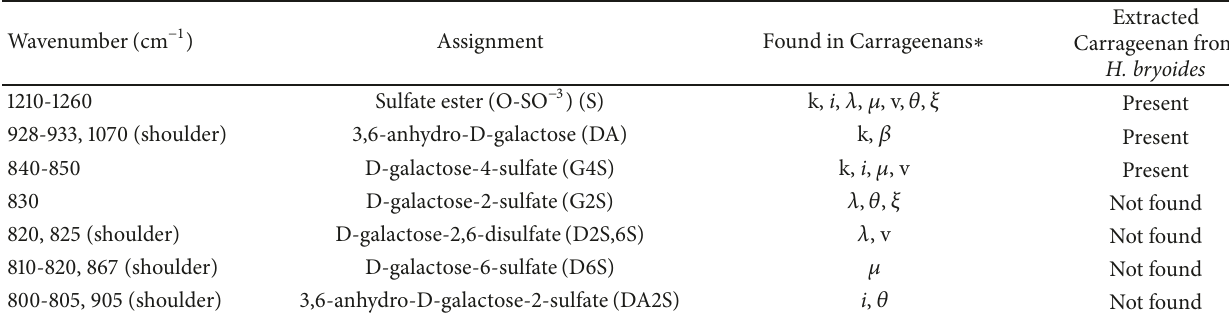
Table 2: Peaks assigned to different carrageenan types.